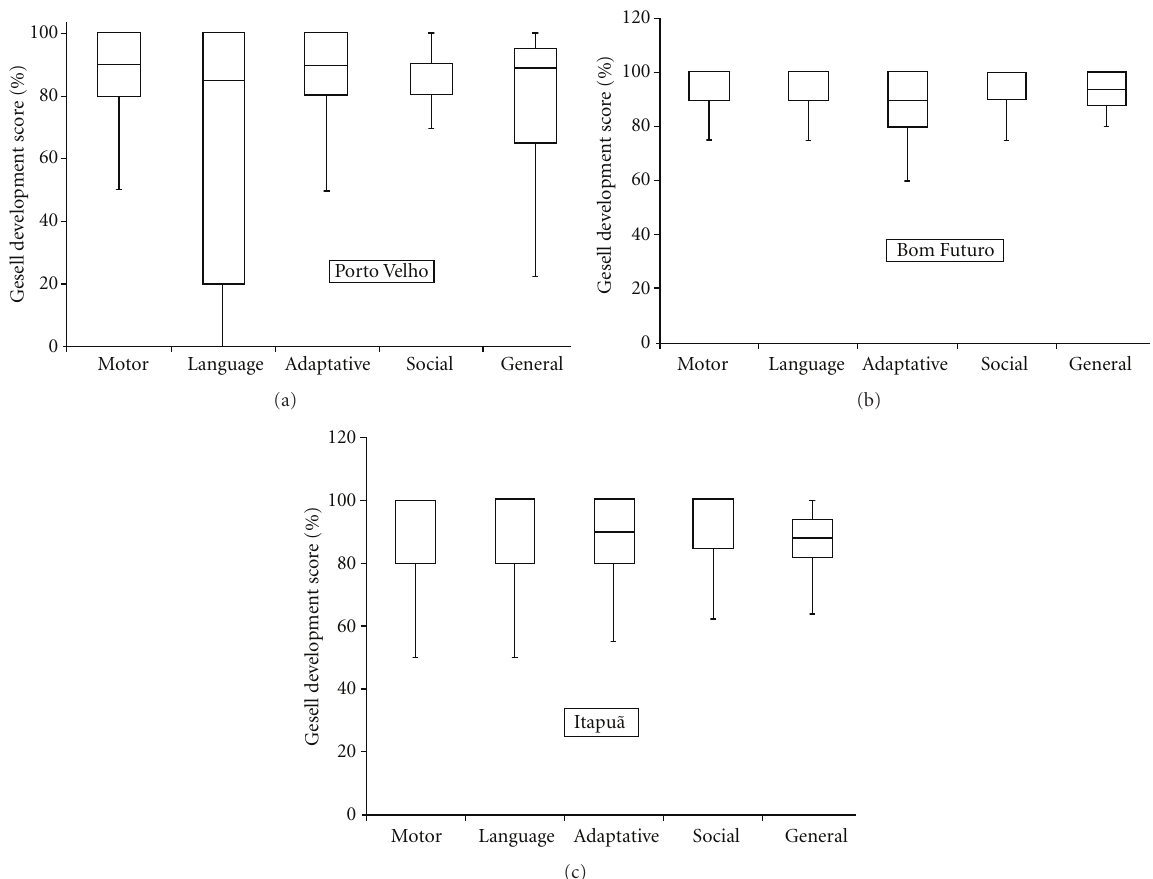
Figure 4: Box plot of Gesell development scores-% ( Y axis) representing PV, BF, and Itapu˜a infants.